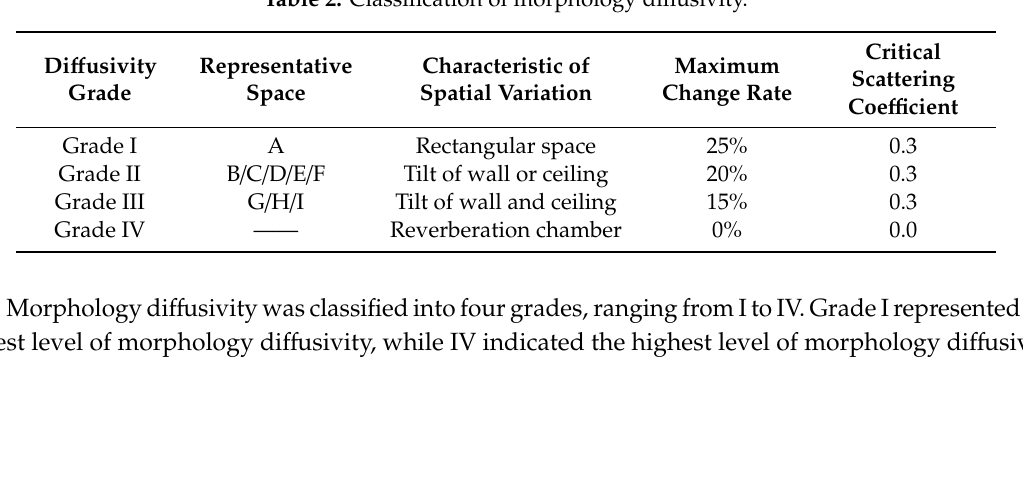
Table 2. Classification of morphology di ff